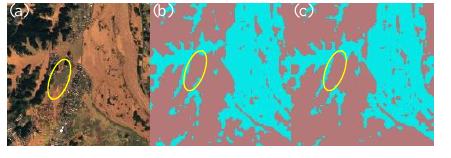
Figure 10. Inundated area mapping with (a) ResNet101 (b) MobileNetV2 models © SPOT image AIRBUS DS